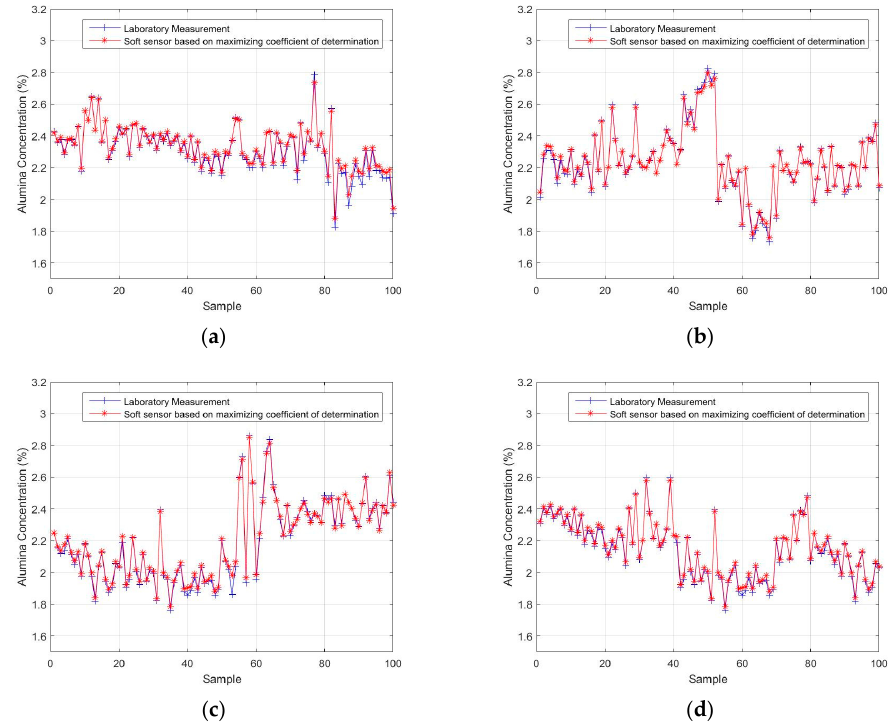
Figure 5. The soft-sensor-estimated alumina concentrations, based on maximizing the coefficient of determination, compared with the actual laboratory measurement using ( a ) the first test subset, ( b ) the second test subset, ( c ) the third test subset, and ( d ) the fourth test subset. Table 4. The RMSE values of the four test subsets.